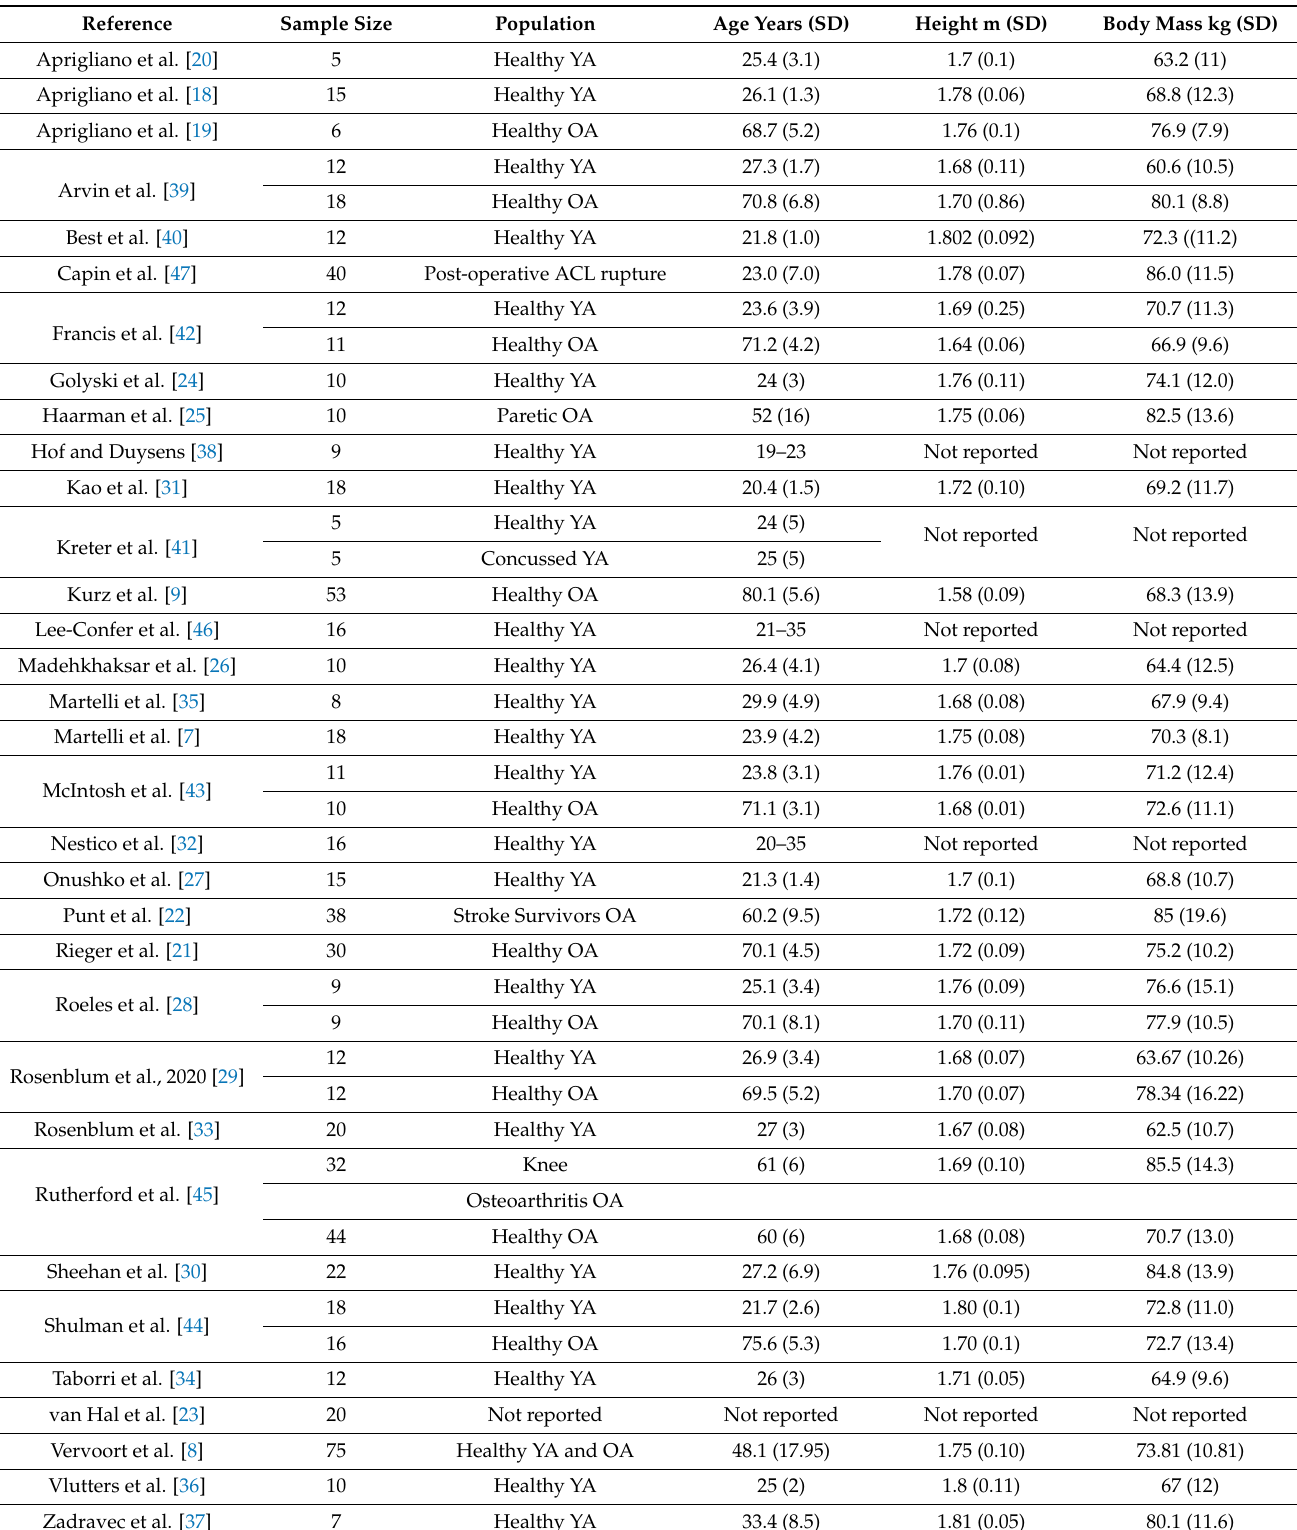
Table 1. Summary of included studies’ participant